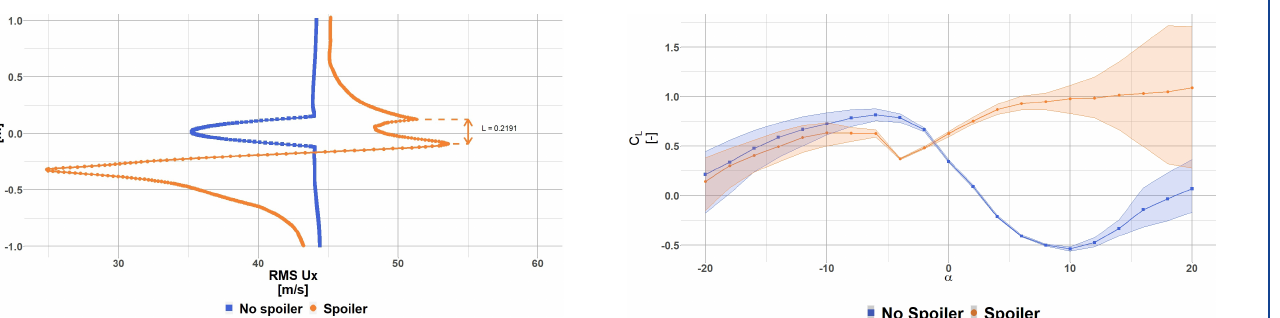
Figure 15. Lift coefficient polar for the radial position R6 ( r = 3. The blue = 13%) and at x c R 13%). The blue square (blue (cid:4) ) shows the C L for the no spoiler case, and the orange dot (orange • ) shows the C L for the spoiler case.